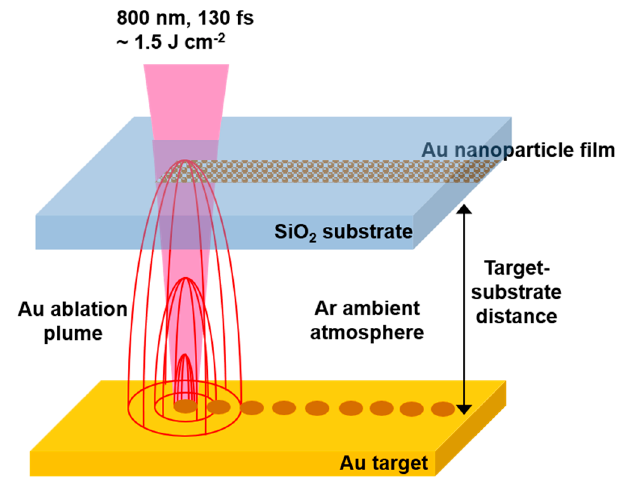
Figure 1. Target and substrate setup used for atmospheric pulsed laser deposition.